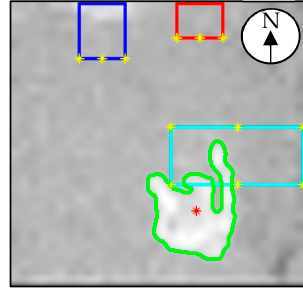
Figure 3. A person sitting at the kitchen table, as seen by the ceiling TIS